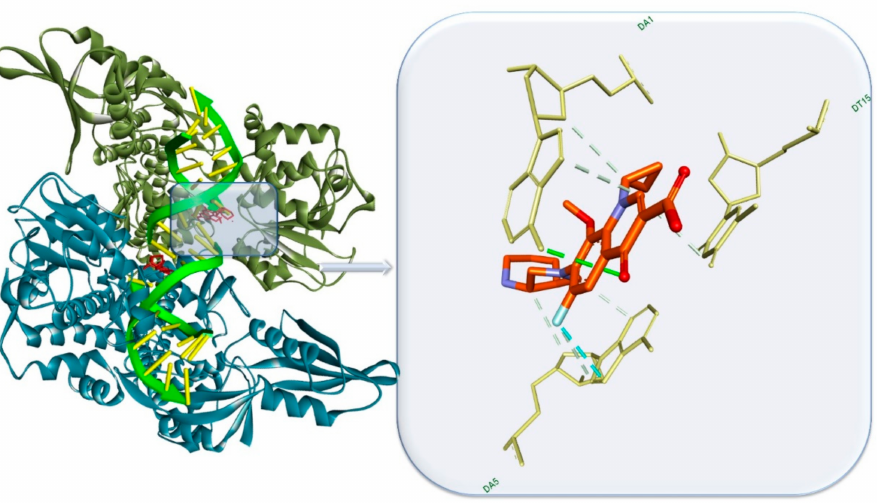
Figure 6. Topoisomerase IV from S. pneumoniae in complex with moxifloxacin (red) and DNA (light green): classical HB are depicted as green dotted lines (DA1), C-H HBs are depicted as light green dotted lines and halogen interactions are depicted as blue dotted lines (DA5); hydrophobic interactions were omitted for better picture clarity. The figure was built with Biovia Discovery Studio 4.1 using the PDB entry